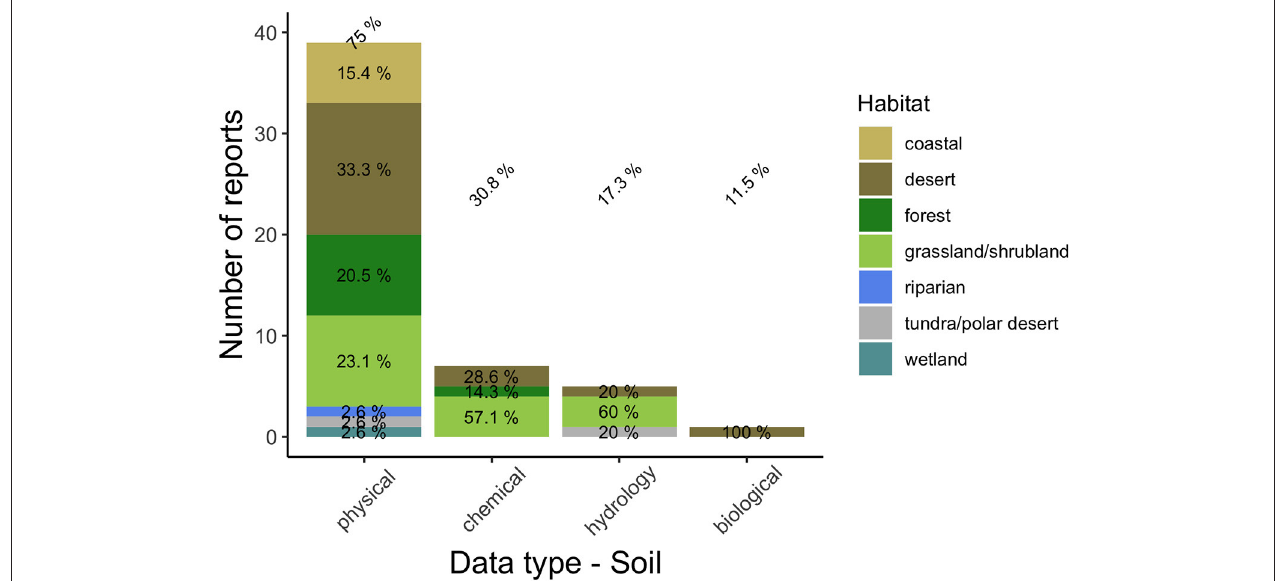
FIGURE 5 | Number of vegetation reports ( n = 38) that accessed the impacts of off-road vehicle (ORV) use across the ecosystem studied. Results are categorized by the type of ecological data collected (biomass, community, cover/abundance, height, injury, population, and seed bank/transport).